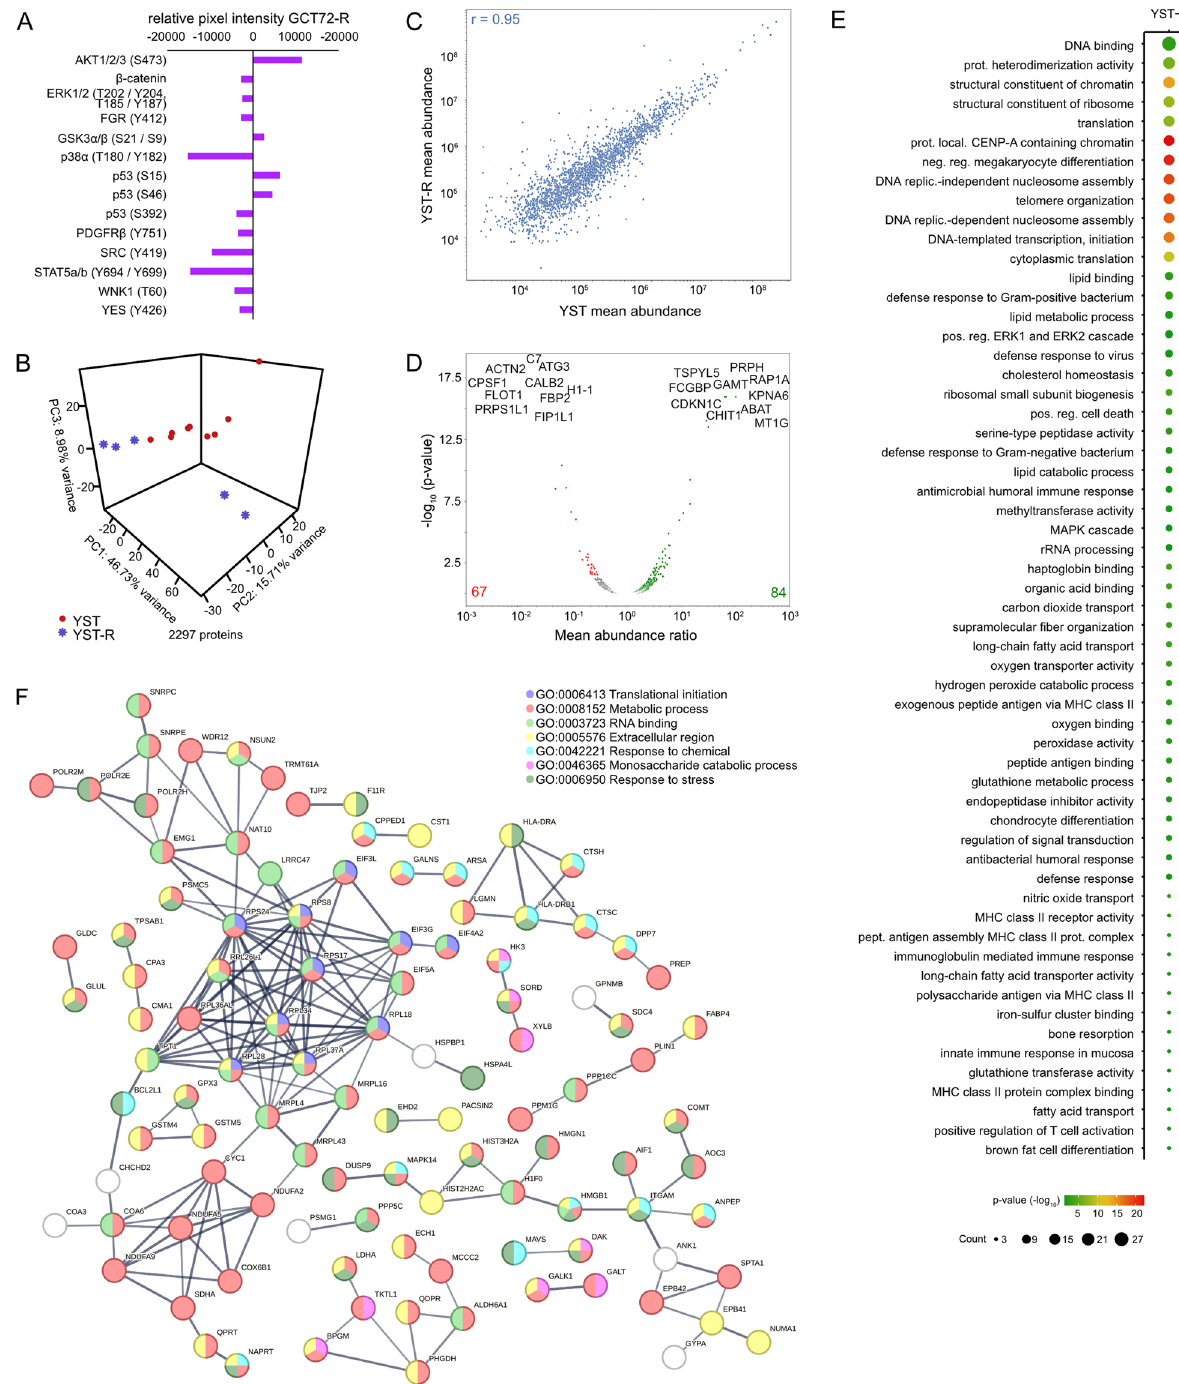
Fig. 4 The molecular resistance mechanisms in YST. A Densitometric evaluation of relative pixel intensities of the most prominent phosphorylation sites in cell lysates from GCT72‑R cells in comparison to the parental cell line, as evaluated by the human phospho‑kinase array. B PCA plot, C Pearson’s correlation plot and D Volcano plot of mass‑spectrometry data of FFPE‑embedded YST(‑R) tissues. E Enrichment plots showing gene ontology terms found exclusively in YST‑R tissues. F STRING interaction analysis of YST‑R‑specific